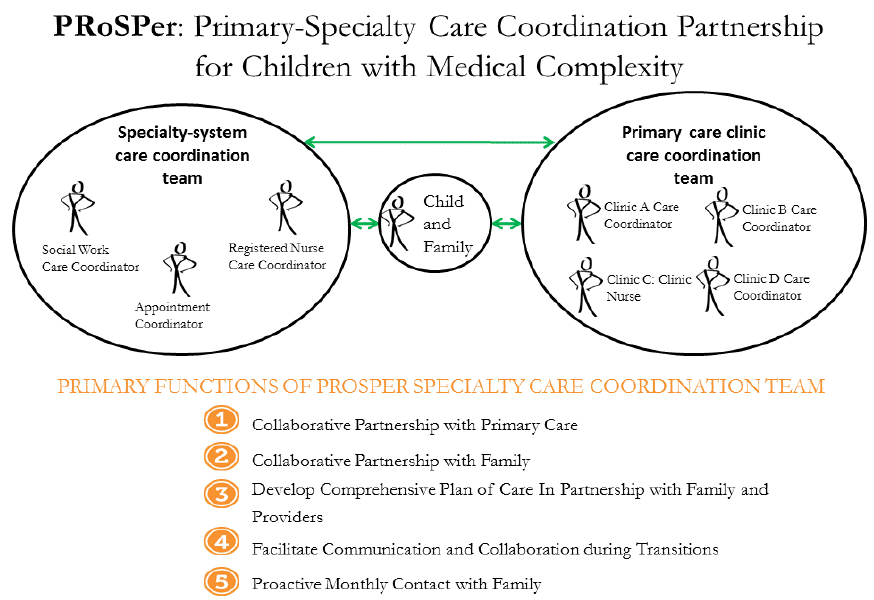
Figure 1. A visual representation of the Primary-Specialty Care Coordination Partnership for Children with Medical Complexity (PRoSPer) model.